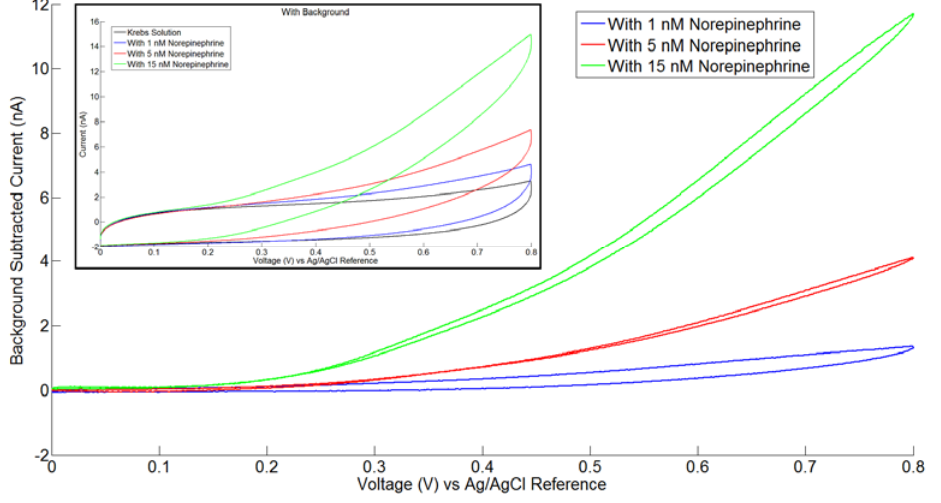
Figure 8. Family of background-subtracted cyclic voltammograms of krebs solution with varying amounts of norepinephrine (NE), demonstrating a lower detection limit of 5 nM or less. The inset shows the cyclic voltammograms before subtracting the krebs solution